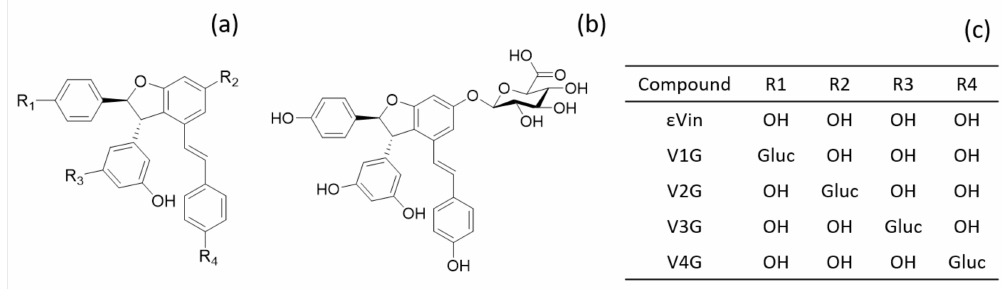
Figure 1. Structure of the 4 isomers of ε Vin. ( a ) basic structure; ( b ) structure of V2G; ( c ) location of glucuronide group (gluc) depending on the